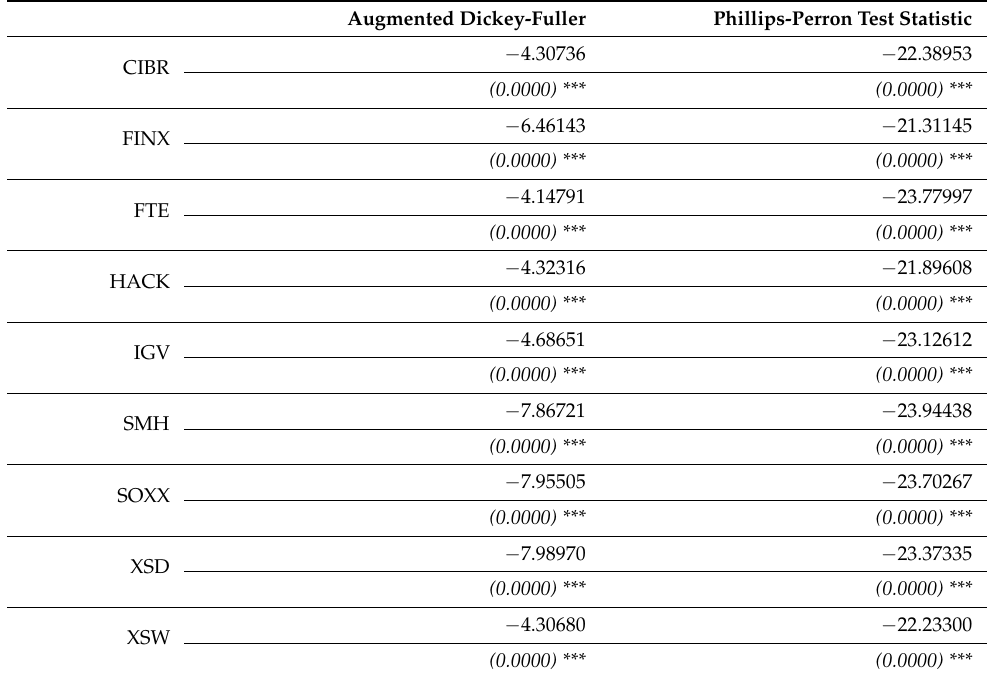
Table A3. Unit Root Test for ETF excess